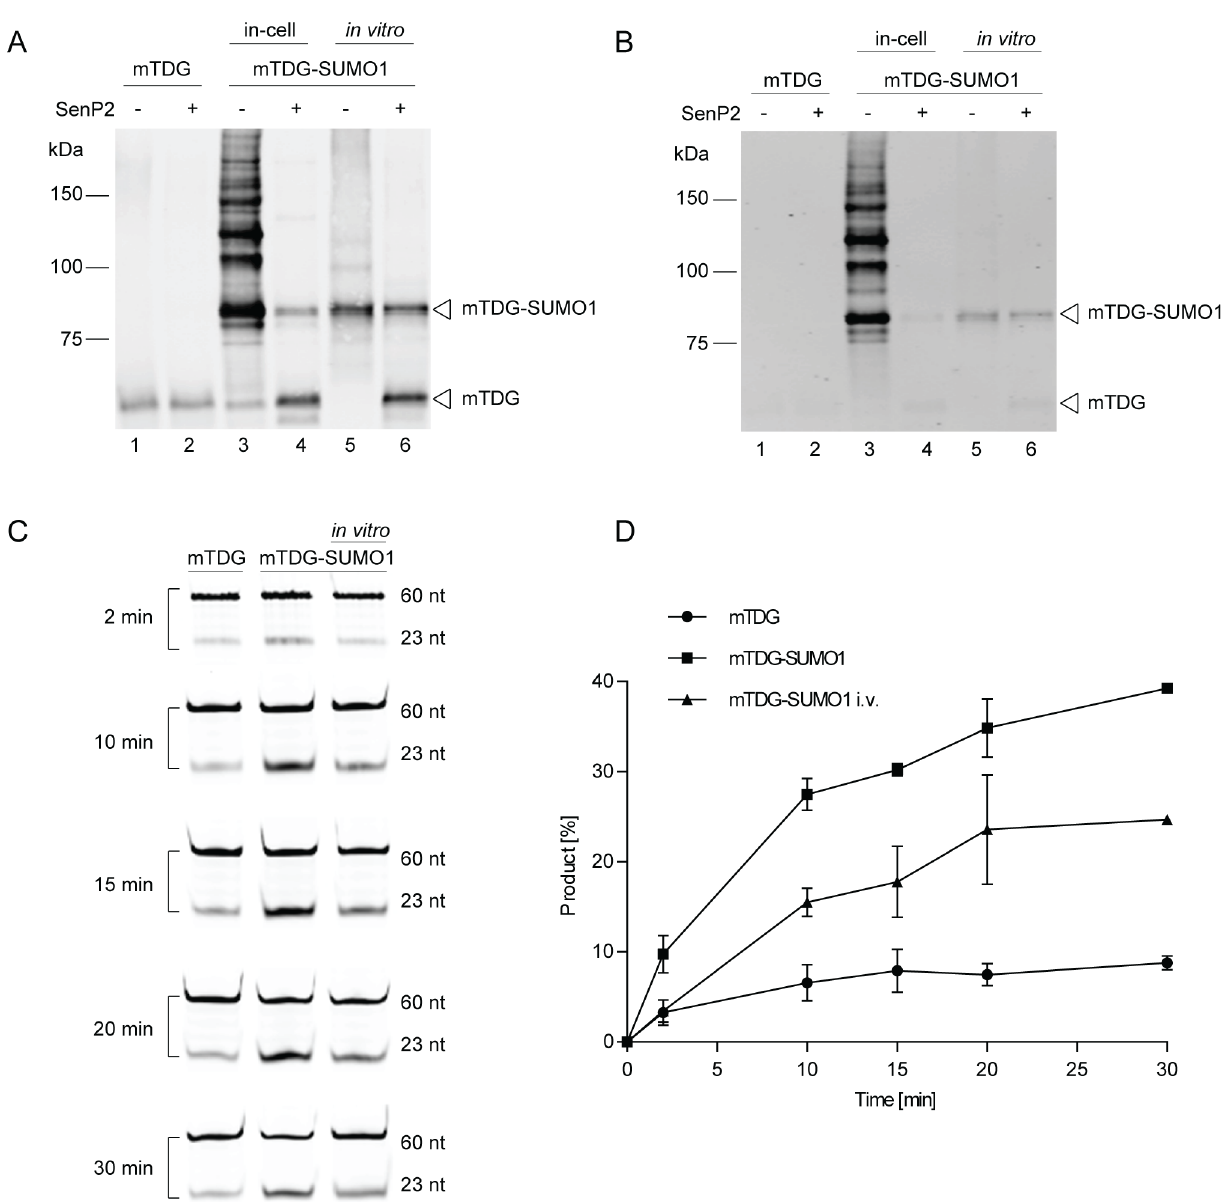
Figure 5. In-cell SUMOylated TDG is active and shows enzymatic turnover. 200 ng of purified mouse TDG (mTDG), purified in-cell SUMOylated mTDG and in vitro SUMOylated samples were analyzed by immunoblot analysis using anti-mTDG ( A ) as well as anti-SUMO1 ( B ) antibodies. Conjugated SUMO1 was cleaved with the recombinant SUMO protease SenP2 at RT for 30 min (lanes 2, 4, 6) and compared to untreated samples (lanes 1, 3, 5). ( C ) Enzymatic activity and turnover of unmodified TDG (mTDG), in vitro (mTDG-SUMO1 i.v.) and purified in-cell SUMOylated TDG (mTDG-SUMO1) were assessed by the base release assay with a 10-fold molar excess of G ? U mismatched oligonucleotides over enzyme. Samples were taken at the indicated time-points and the relative amounts of processed 23 nucleotide product (23 nt) versus unprocessed 60 nucleotide substrate (60 nt) was quantified and depicted in ( D ). Error bars, SEM of 2 experiments.